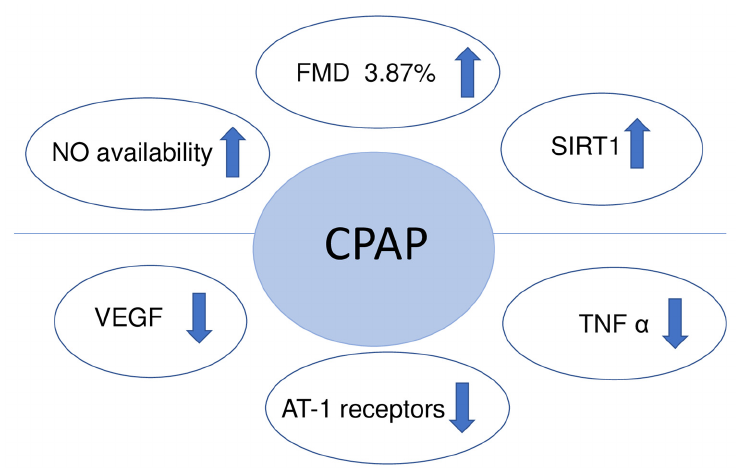
Figure 3. Endothelial function after treatment with CPAP. Abbreviations: VEGF: vascular endothelial growth factor; NO: nitric oxide; FMD: flow mediated dilation; SIRT1: sirtuin 1; TNF α : tumor necrosis factor alpha; AT-1 receptors: expression of angiotensin receptors type-1; ↑ : increased; ↓ : decreased.